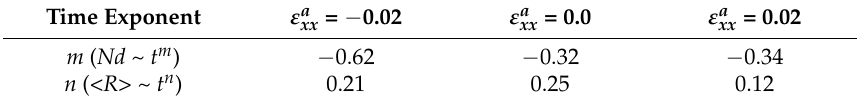
Figure 4. The temporal evolution of the volume fraction Vf ( a ) and particle number density Nd ( b ) of the α′ phase in Fe-28 at. % Cr alloy aged at 750 K under applied strain for 3D simulation, and the variation rates of Vf and Nd of the α′ phase as a function of applied strain ( c ). Table 2. The time exponent m for Nd and n for < R > of α′ phase in Fe-28 at. % Cr alloy aged at 750 K. Table 2. The time exponent m for Nd and n for < R > of α (cid:48) phase in Fe-28 at. % Cr alloy aged at 750 K.